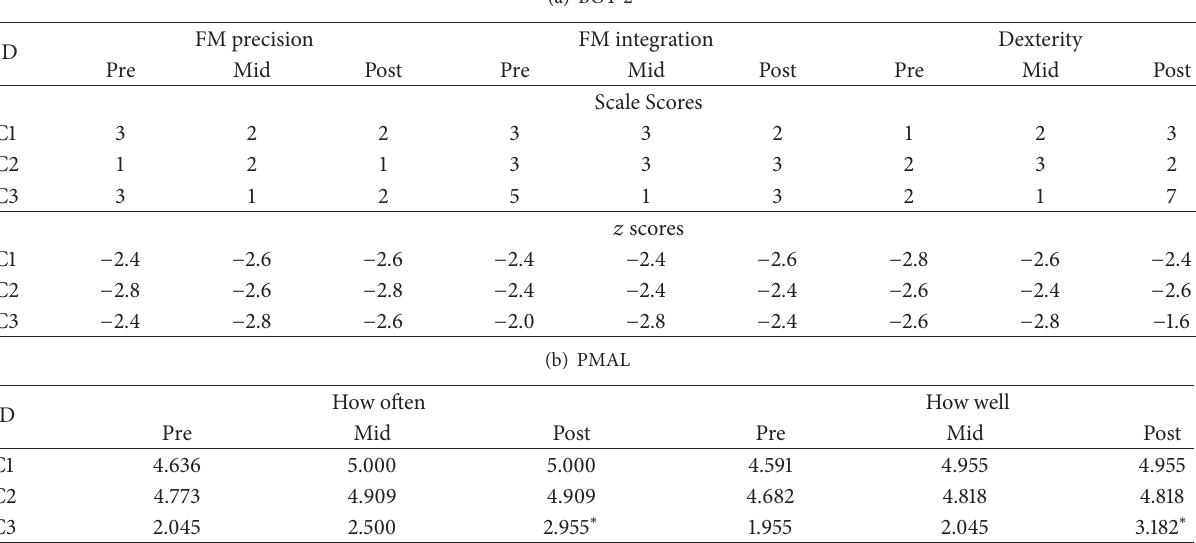
Table 3: The scores on BOT-2 (a) and PMAL (b) in children with CP. The 𝑧 score of BOT-2 is also listed in Table 3(a). The MDC reported from the literature was 0.67 for the PMAL-Amount (i.e., how often) and 0.66 for the PMAL-Quality (i.e., how